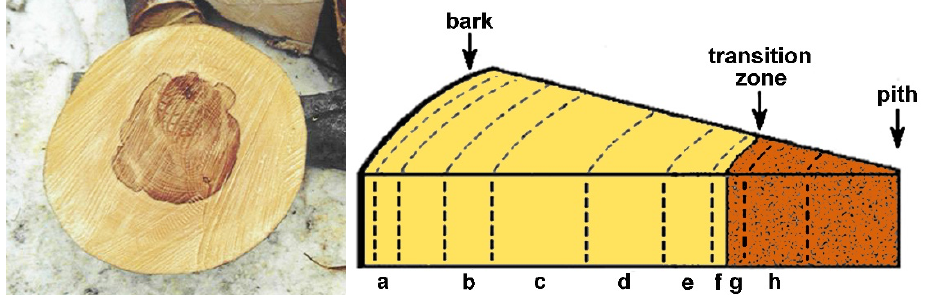
Figure 1. The graphic description of the assignment of wood sections from sample disks; a–e: outer and inner sapwood tissues; f/g: sapwood/red heartwood transition zone; h: inner red heartwood.